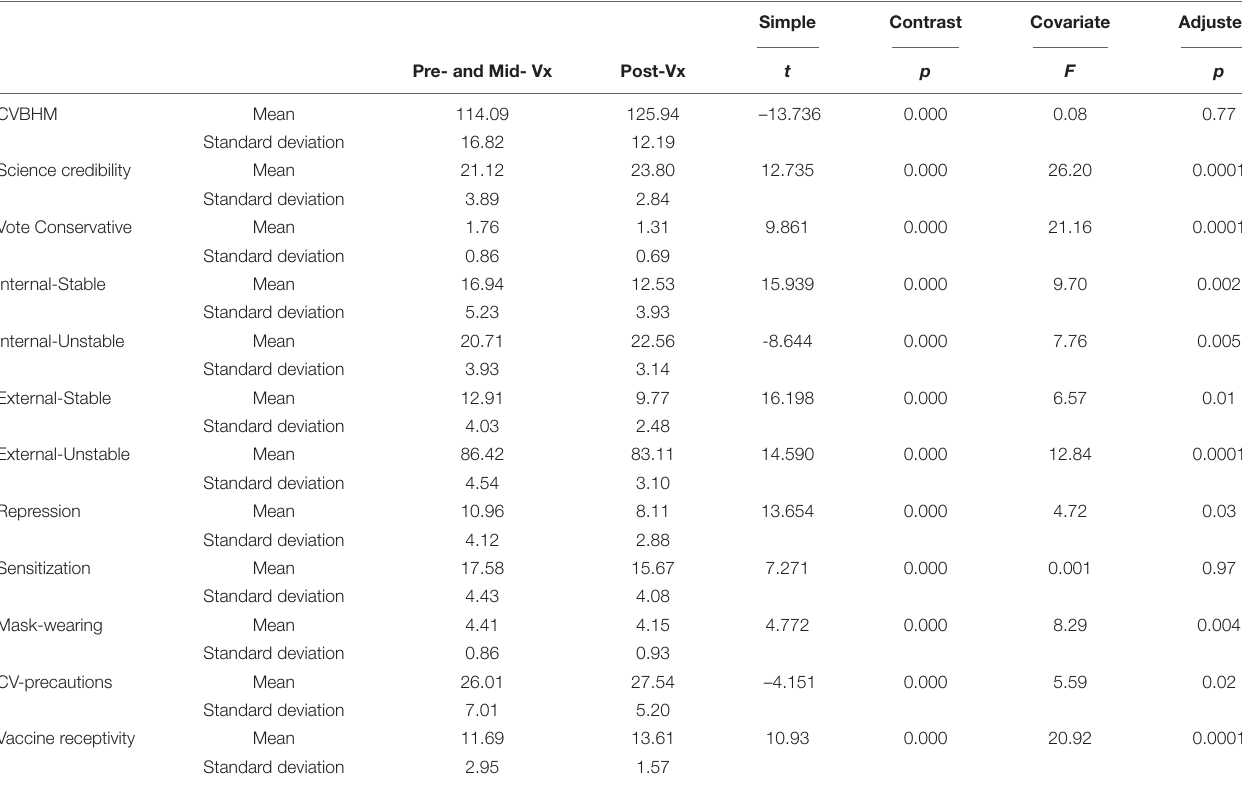
TABLE 9 | Attitude, attribution and coping differences between Study 1 (Pre-Vx and Mid-Vx) versus Study 3 (Post-Vx) samples (Study 3).